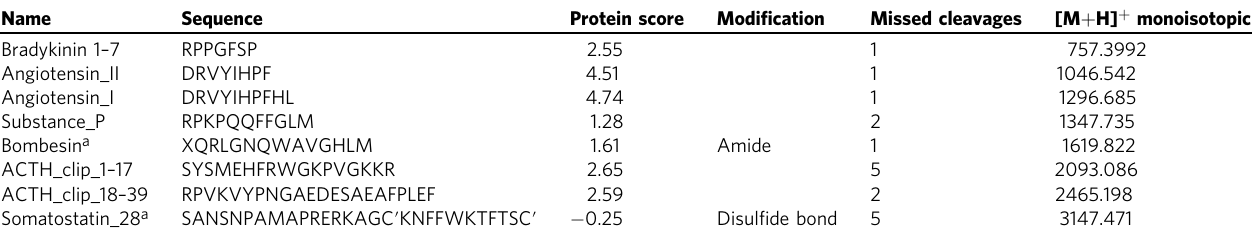
Table 1 Characteristics and identi fi cation parameters of Bruker ’ s Peptide Calibrant II.